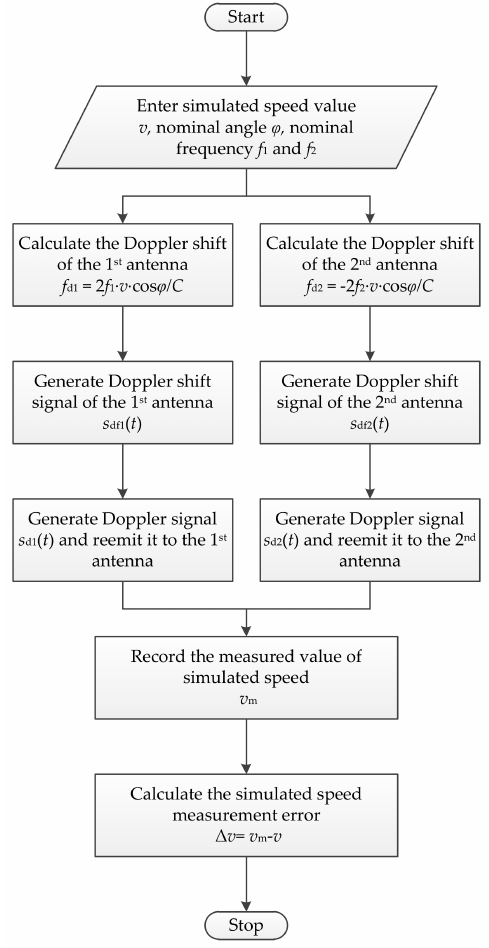
Figure 9. Flow diagram of dual Doppler shift simulation system for the